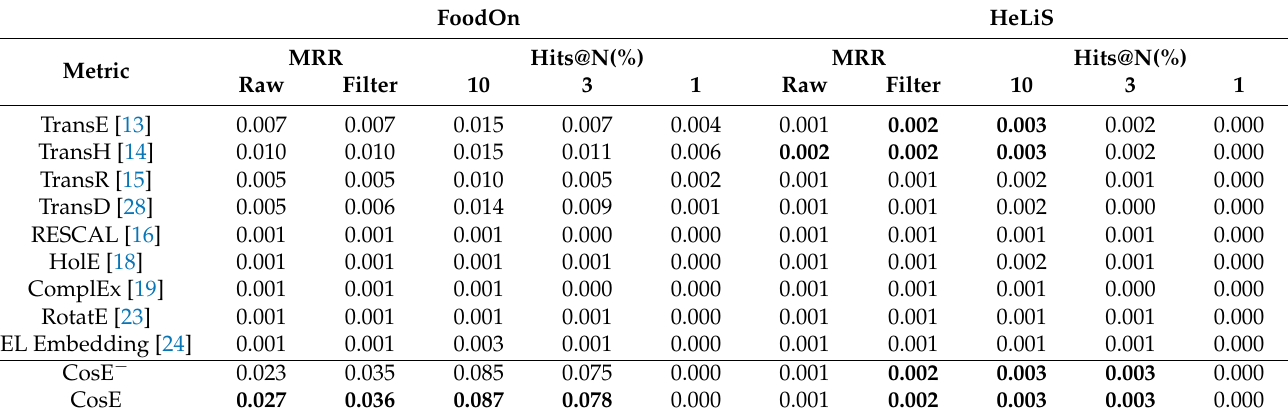
Table 7. The results of FoodOn and HeLiS on link prediction about disjointWith